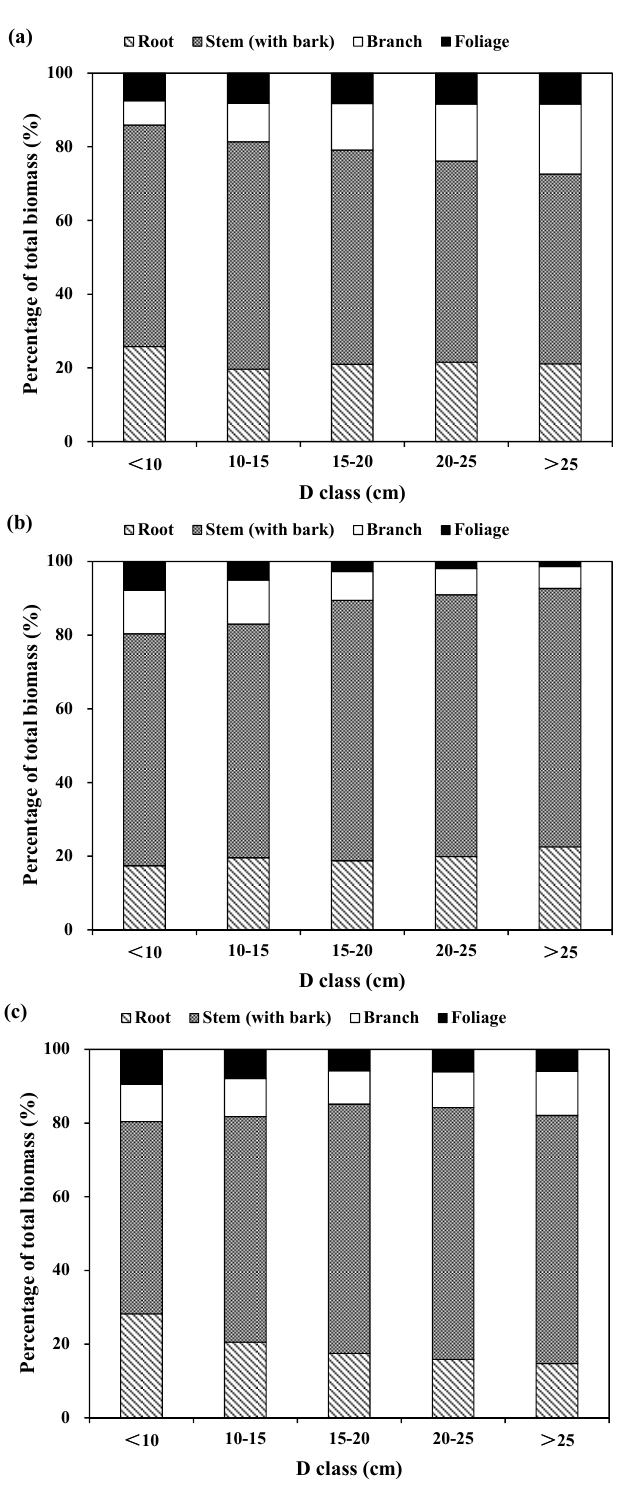
Figure 2. Biomass partitioning of aboveground and belowground components across a range of diameter classes (the first column; <10 cm, 10–15 cm, 15–20 cm, 20–25 cm and >25 cm): ( a ) Korean pine; ( b ) Larch; and ( c ) Mongolian pine.